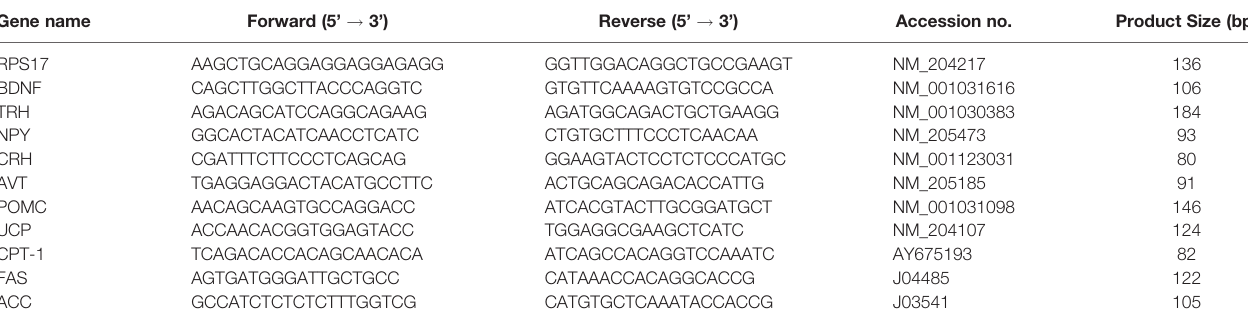
TABLE 1 | Primer sequences for real time PCR.